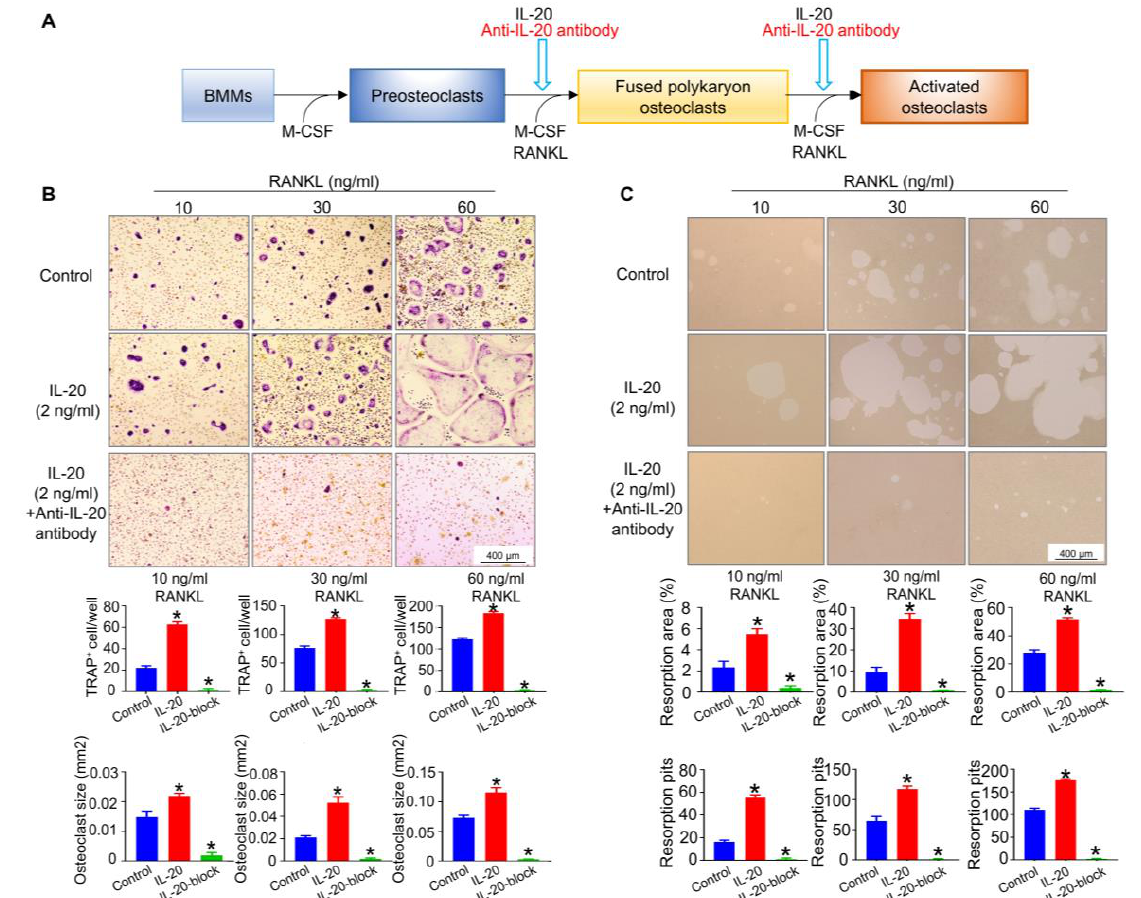
Figure 4. IL-20 promoted RANKL-induced osteoclast differentiation and bone resorption function. ( A ) Scheme illustrating M-CSF-induced preosteoclasts were cultured in osteoclast medium containing IL-20 or anti-IL-20 antibody at the late stage of osteoclast differentiation in the presence of 10, 30, or 60 ng/mL RANKL. ( B ) TRAP staining was performed, and the number and size of TRAP-positive osteoclasts with more than three nuclei were quantified at the late stage of differentiation on day 6. The control group included M-CSF-induced preosteoclasts induced with 10, 30, or 60 ng/mL RANKL. IL-20-block group meant that cells were treated with IL-20 and anti-IL-20 antibody. ( C ) A resorption pit assay was performed to detect osteoclast function, and resorption pits were counted at the late stage of differentiation on day 6, and the area and number of bone resorption were quantified at the stage of differentiation. IL-20-block group meant that cells were treated with IL-20 and anti-IL-20 antibody. * p < 0.05 vs. the control group. n =